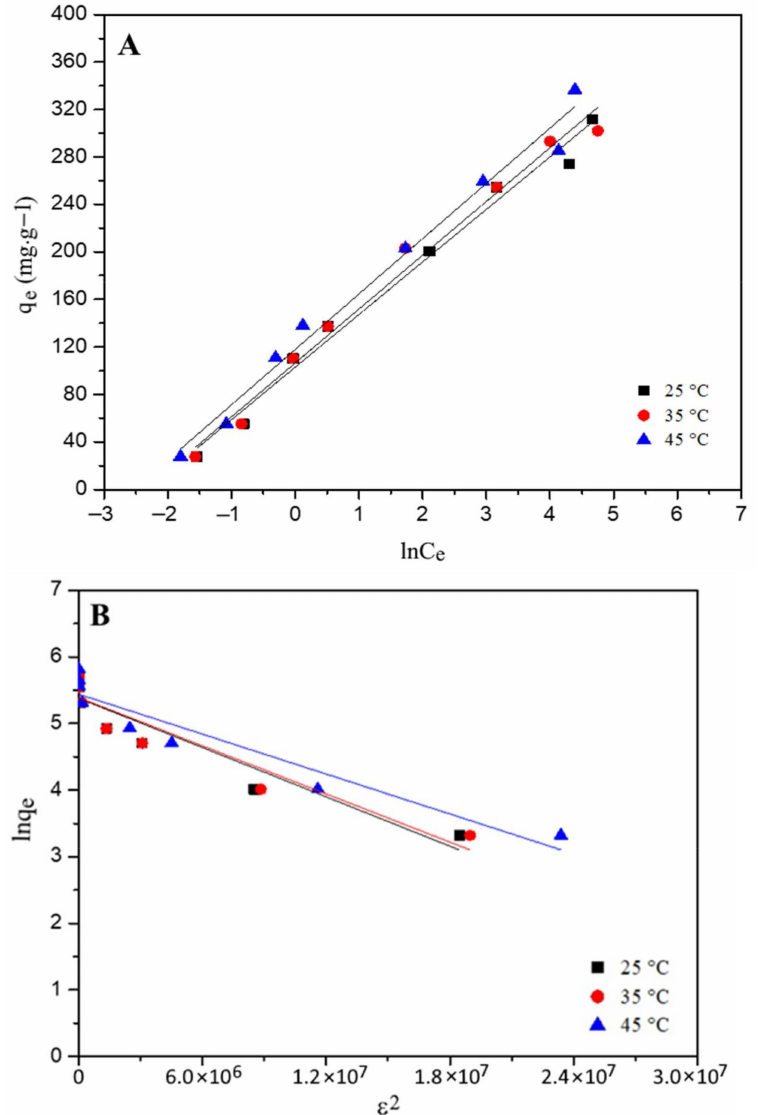
Figure 5. Temkin ( A ) and D-R ( B ) adsorption isotherms of 2-NP on DKLAAC at different temperatures (25 ◦ C, 35 ◦ C, and 45 ◦